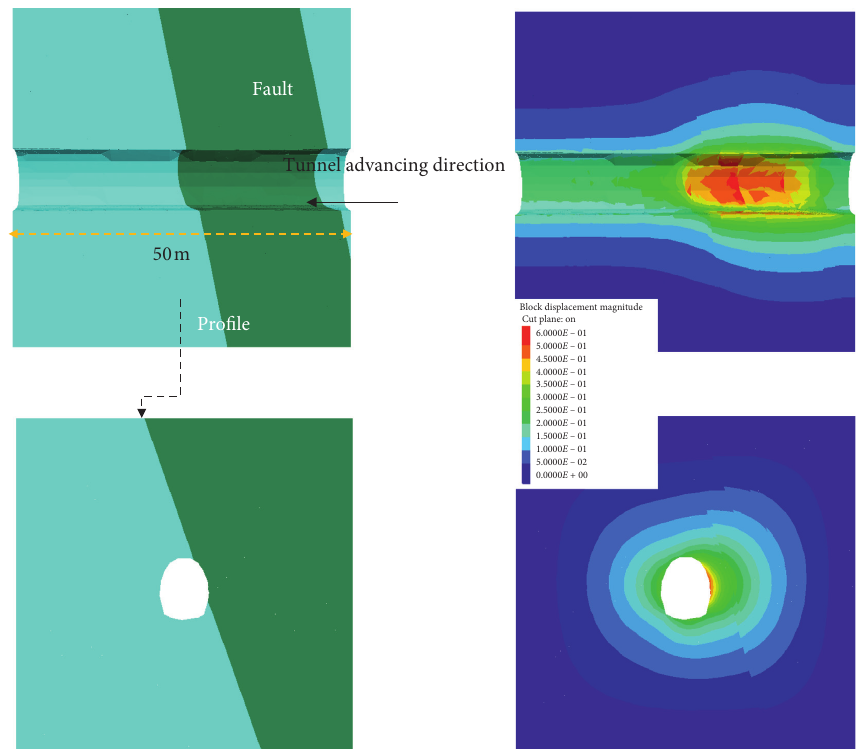
Figure 7: 50m of tunnel entering fault.